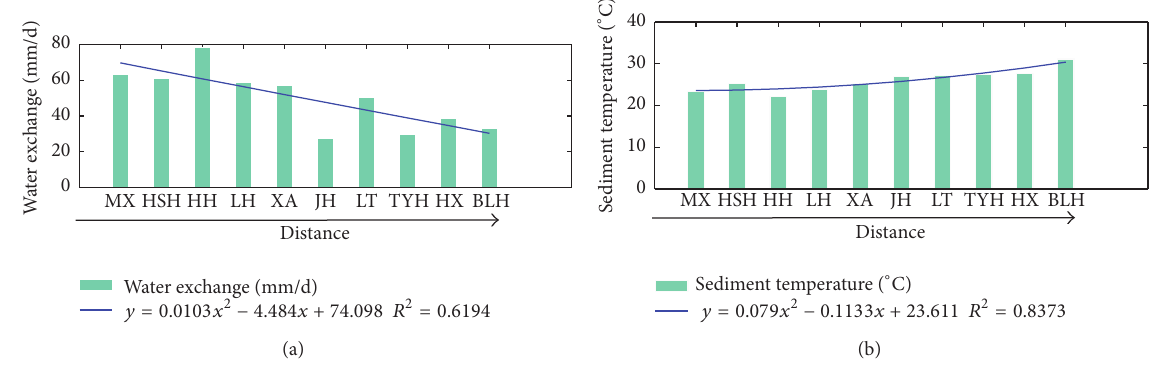
Figure 7: The treads of hyporheic water exchange and temperature with the upstream of the Weihe